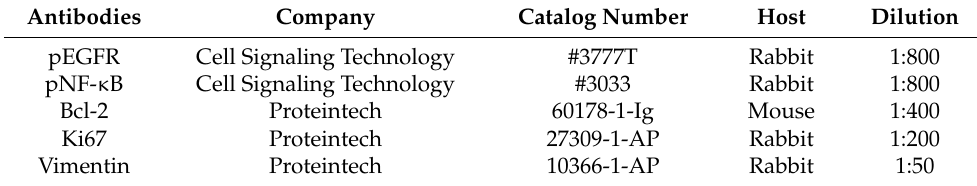
Table 3. Antibodies used in